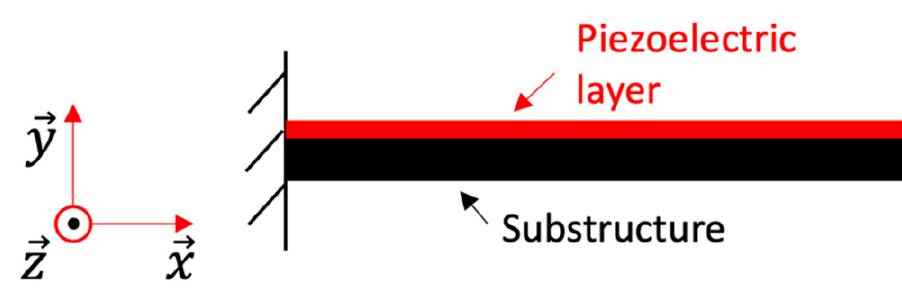
Figure 1. Schematic of a clamp-free unimorph beam.